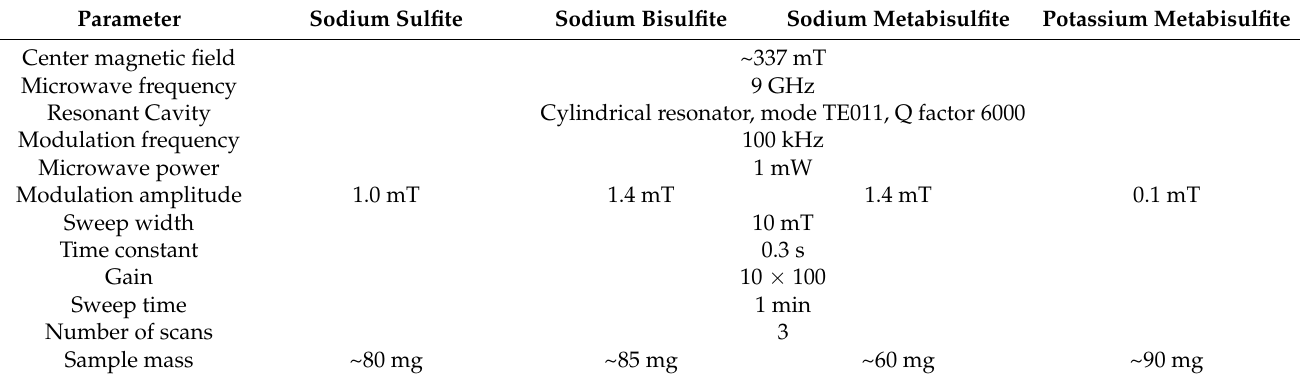
Table 2. X-band ESR spectrometer settings for Dose–Response